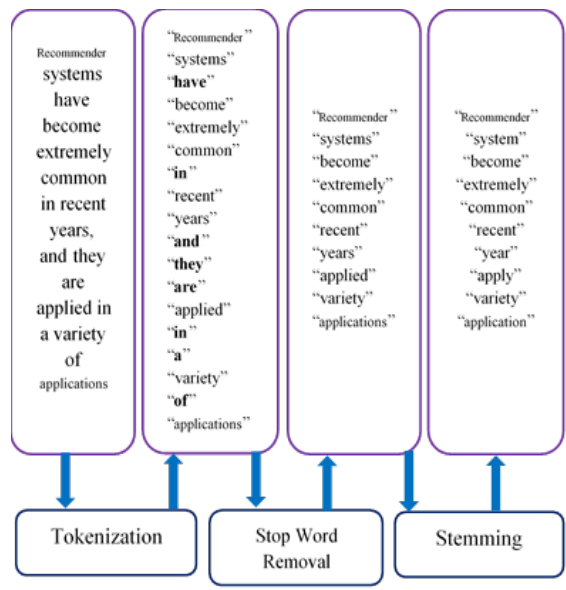
Figure 4. Tokenization, Stop-Word Removal, and Stemming process of extracted